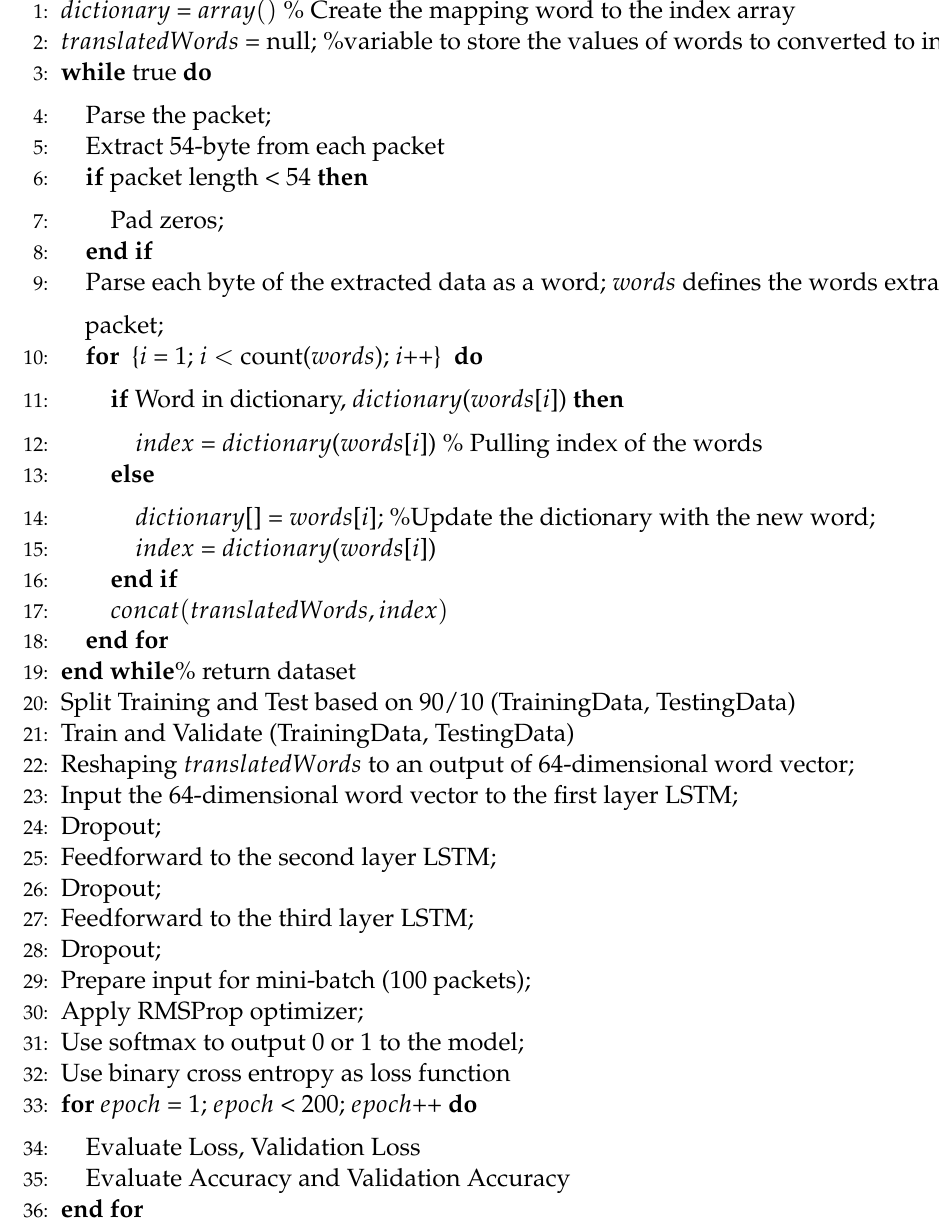
Algorithm 1: Algorithm for packet-based traffic classification Data: Sequence of raw packets from